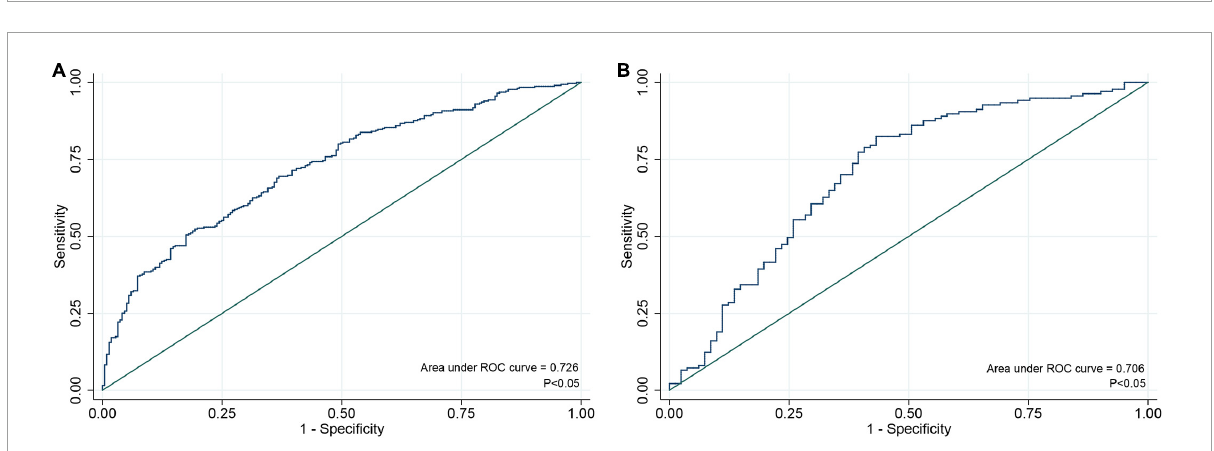
FIGURE4 ROC curve for individualized prediction model to predict 3-month poor outcome in training set (A) and validation set (B) . ROC, receiver operating characteristic.